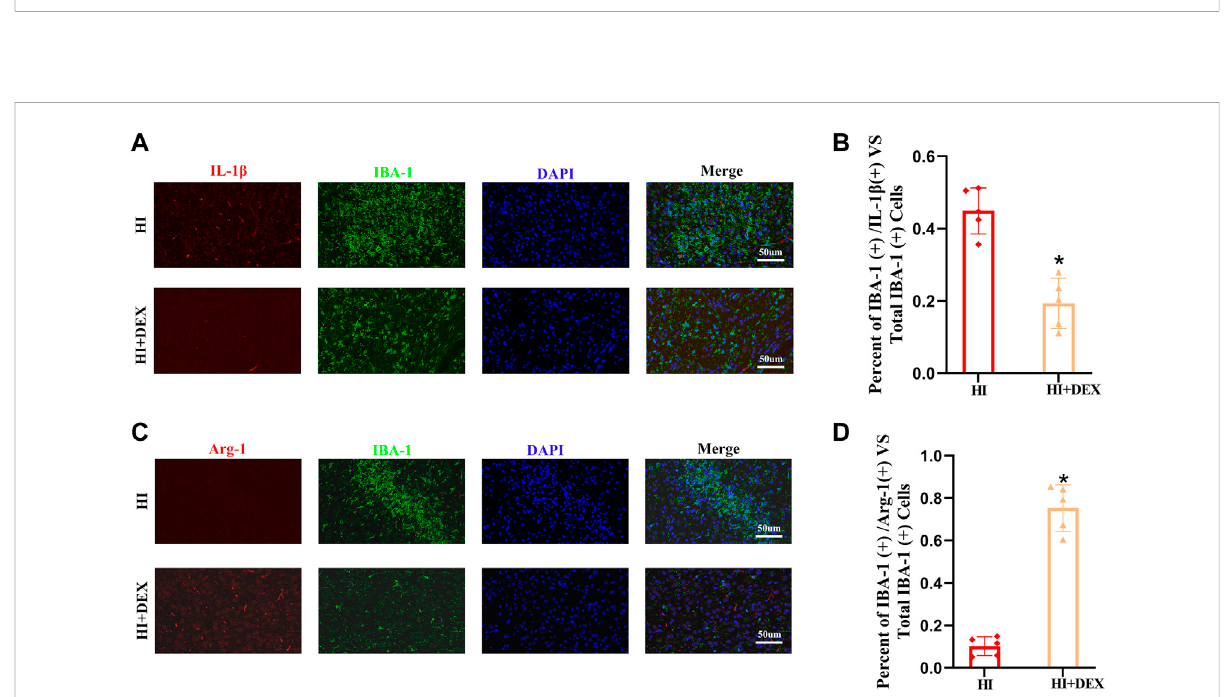
FIGURE 6 DEX promoted the polarization of microglia from the M1 to M2-like phenotype in neonatal rats with HIBD. Brain sections from the ipsilateral hemisphere on D2 were stained for anti-IBA-1 antibody (green) and (A) for anti-IL-1 β , a marker for the M1 phenotype (red); and (C) for anti-Arg-1, a markerfor theM2phenotype(red). (A – D) RepresentativeIFimages(magni fi cation×400, scale bar:50 μ m)and semi-quantitativeanalysis(barchart) of the ratios of IBA-1 + \ IL-1 β + vs . total IBA-1 + and IBA-1 + \ Arg-1 + vs . total IBA-1 + showing the status of microglia polarization. DEX, Dexmedetomidine; HIBD, Hypoxic-ischemic brain damage; D2, 2 days after HIBD. Data are expressed as the mean ± SD ( n = 5 per group). * p < 0.05 vs. the HI group.